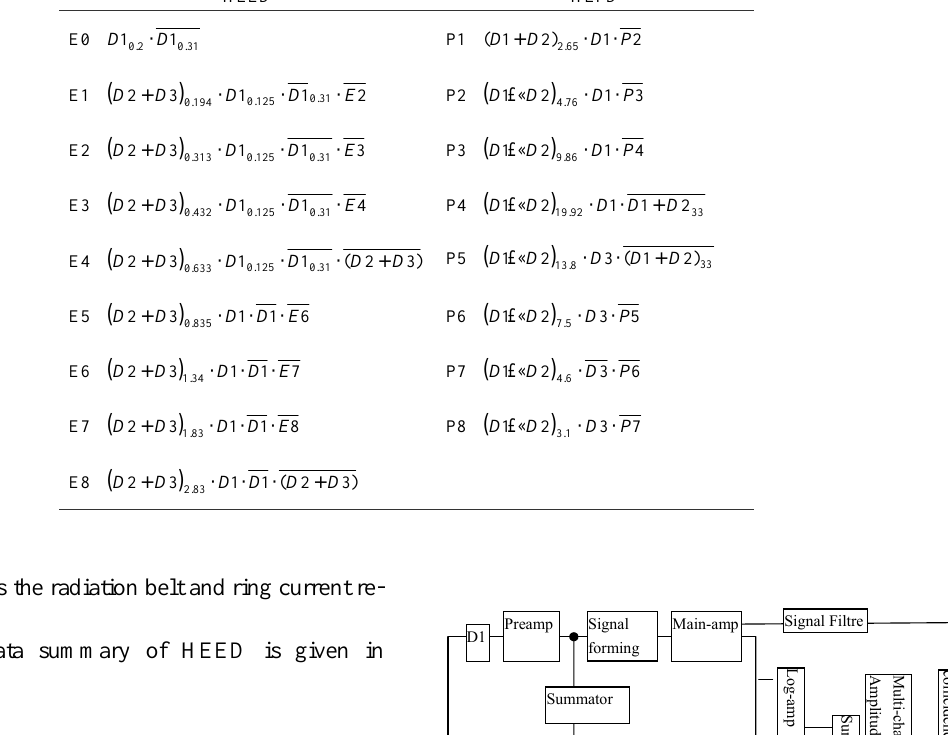
Table 1. Determination criteria of electrons of HEED and protons of HEPD. Table 1 Determination criteria of electrons of HEED and protons of HEPD. HEED HEPD